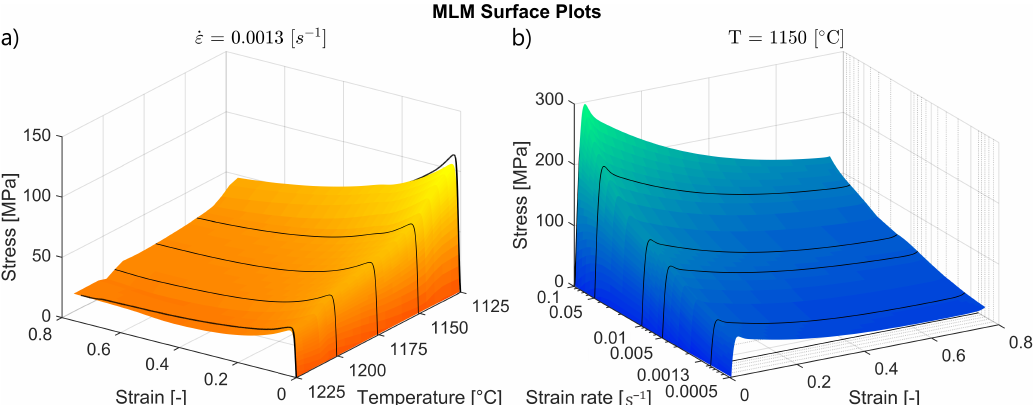
Figure 13. Surface plots of stress values predicted by the MLM for interpolated and extrapolated inputs; ( a ) temperatures between 1125 and 1225 ◦ C with an increment of 5 ◦ C, ( b ) strain rates between 0.0005 and 0.1 s –1 with 10 increments between each power.